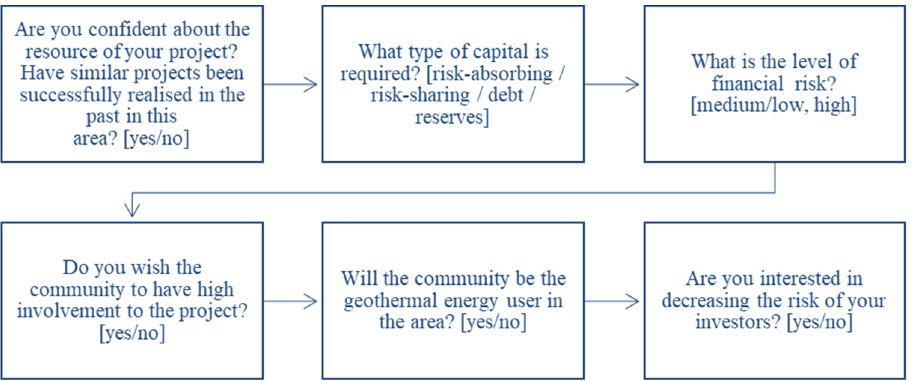
Figure 11. Decision tree’s sequence of questions to identify appropriate funding solutions.